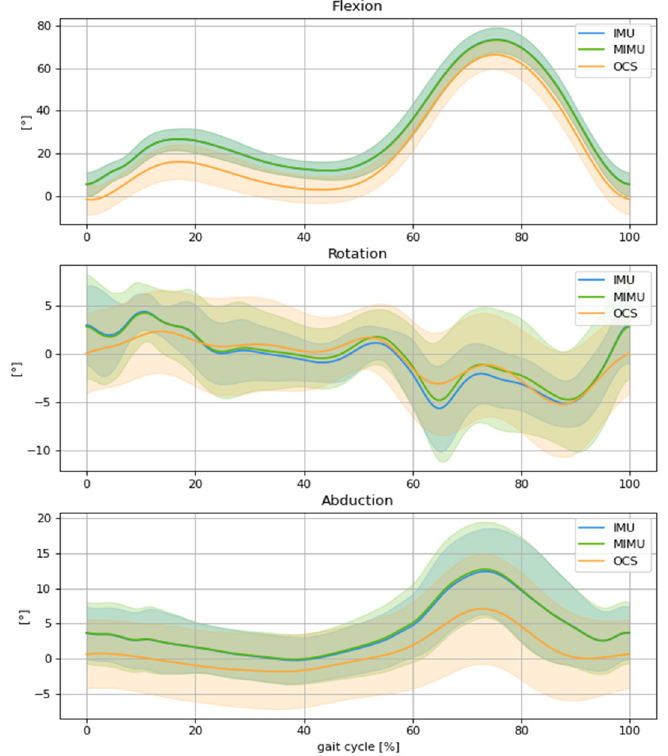
Figure 4. Comparison of mean knee kinematics, normalized to the gait cycle, between the OCS (orange), IMUs (blue), and MIMUs (green), involving flexion, external rotation, and abduction for spontaneous gait speed.